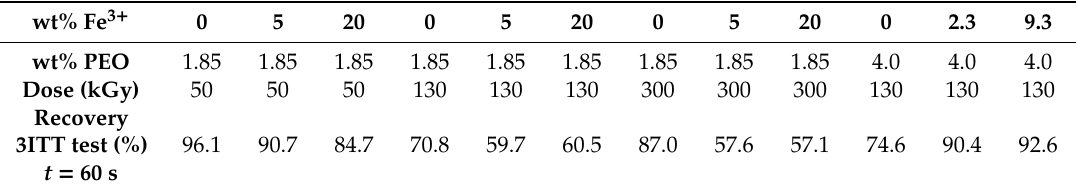
Table 3. Self-recoverable properties of pure PEO gels and nanocomposite gels obtained at various doses and compositions of precursor suspensions determined in 3-interval thixotropy